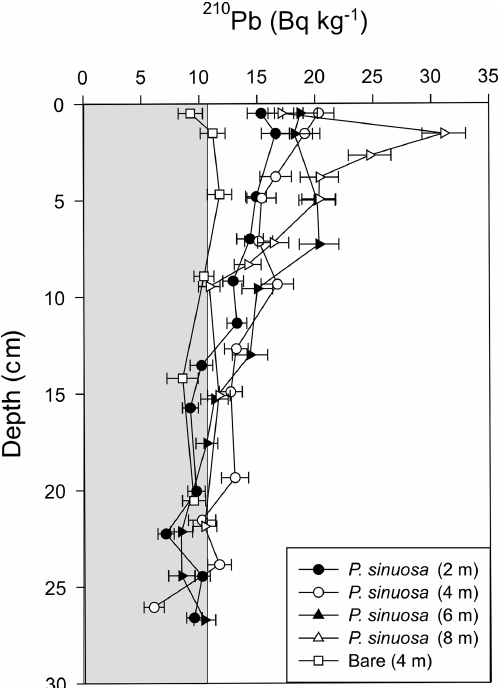
Figure 3. Concentration profiles of total and excess 210 Pb in sea- grass and bare sediment cores from Cockburn Sound. Gray shaded area indicates the concentration of supported 210 Pb ( 210 Pb sup )